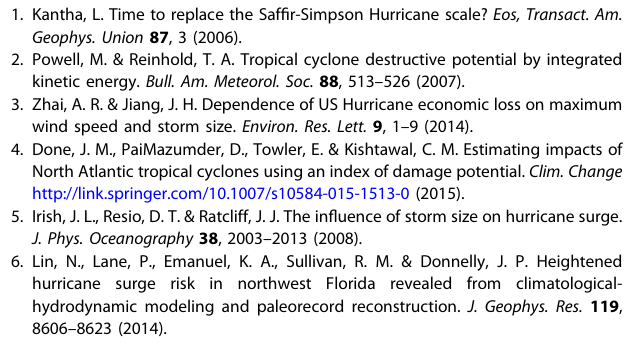
Fig. 6 after the following pre-processing procedures: